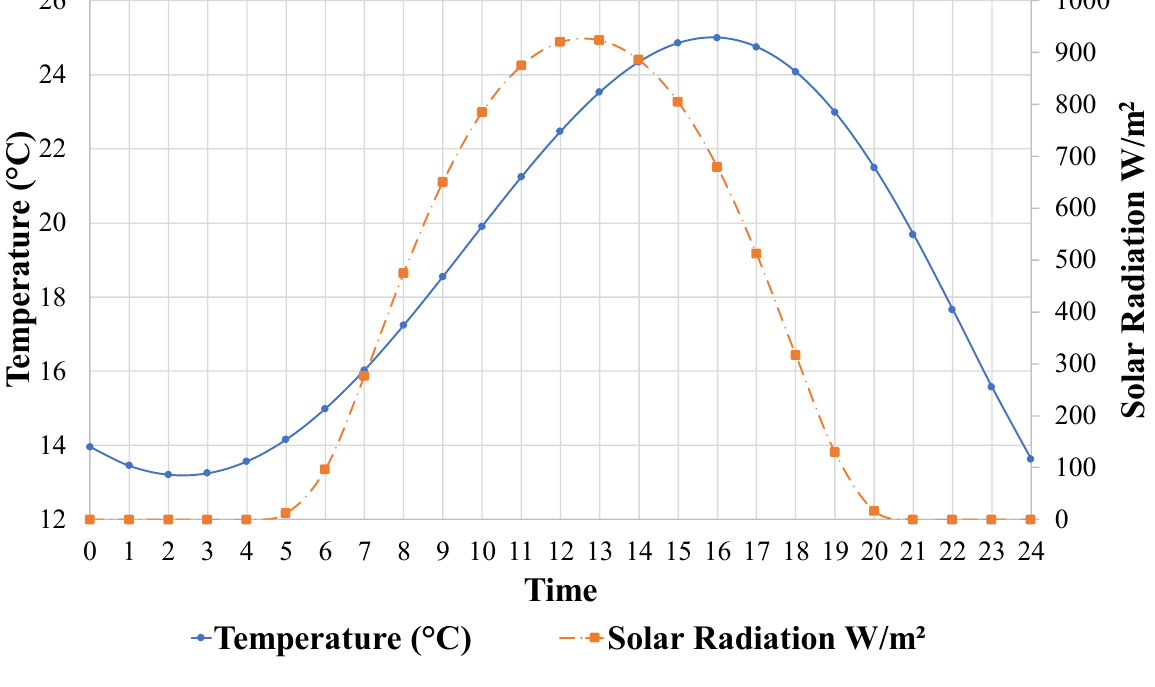
Figure 7. Temperature and solar radiance trends for the 24 June 2021, in Newark, Delaware [67].